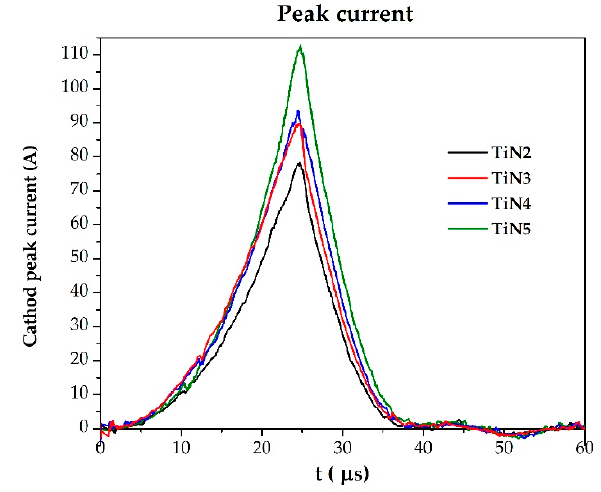
Figure 1. HiPIMS peak current variation (pulse time = 25 µs) while changing the nitrogen flux during the deposition process. The example cases of TiN2 (1 sccm N 2 ), TiN3 (1.2 sccm), TiN4 (1.5 sccm N 2 ), and TiN5 (2 sccm N 2 ) are shown.